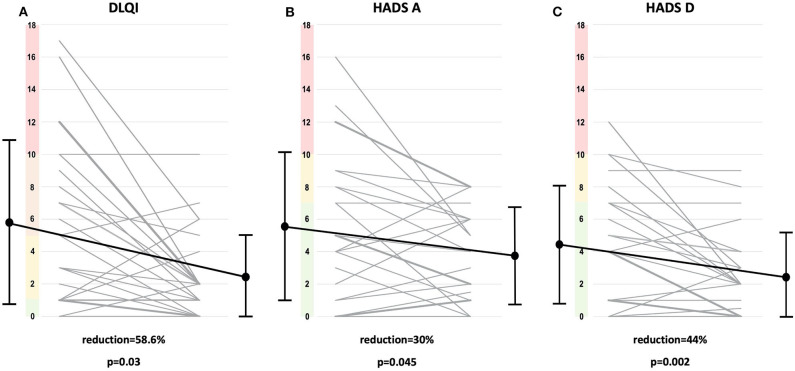
DLQI and HADS scores. Individual overall values of Dermatology Life Quality Index (DLQI) (A) and the Hospital Anxiety and Depression scale HADS-A (B) and HADS-D (C) of the 24 patients prior to (left side) and after psoralen-UV-A (PUVA) induction (right side) and their specific evolution (gray line) are shown. Thickness of gray lines is proportional to the number of patients and their DLQI, HADS-A, or HADS-D evoluting in a certain way. Range of DLQI severity groups are colorized on the y-axis of the plot: no impairment (green; 0–1 points); slight (yellow; 2–5), moderate (orange; 6–10), and severe (red; >10 points) impairment. Range of HADS severity groups colorized on the y-axis of the plots: no signs of anxiety/depression (green; 0–7 points), borderline abnormal (yellow; 8–10), abnormal values (red; >10 points). Mean values (black dots), standard deviations (black intervals), and evolution of means (black lines) prior to (left side) and after (right side) PUVA treatment are plotted. Percentages of reduction comparing overall scores prior to and after PUVA treatment are depicted. Statistical significance was determined by Wilcoxon signed-rank test and respective p-values are plotted.